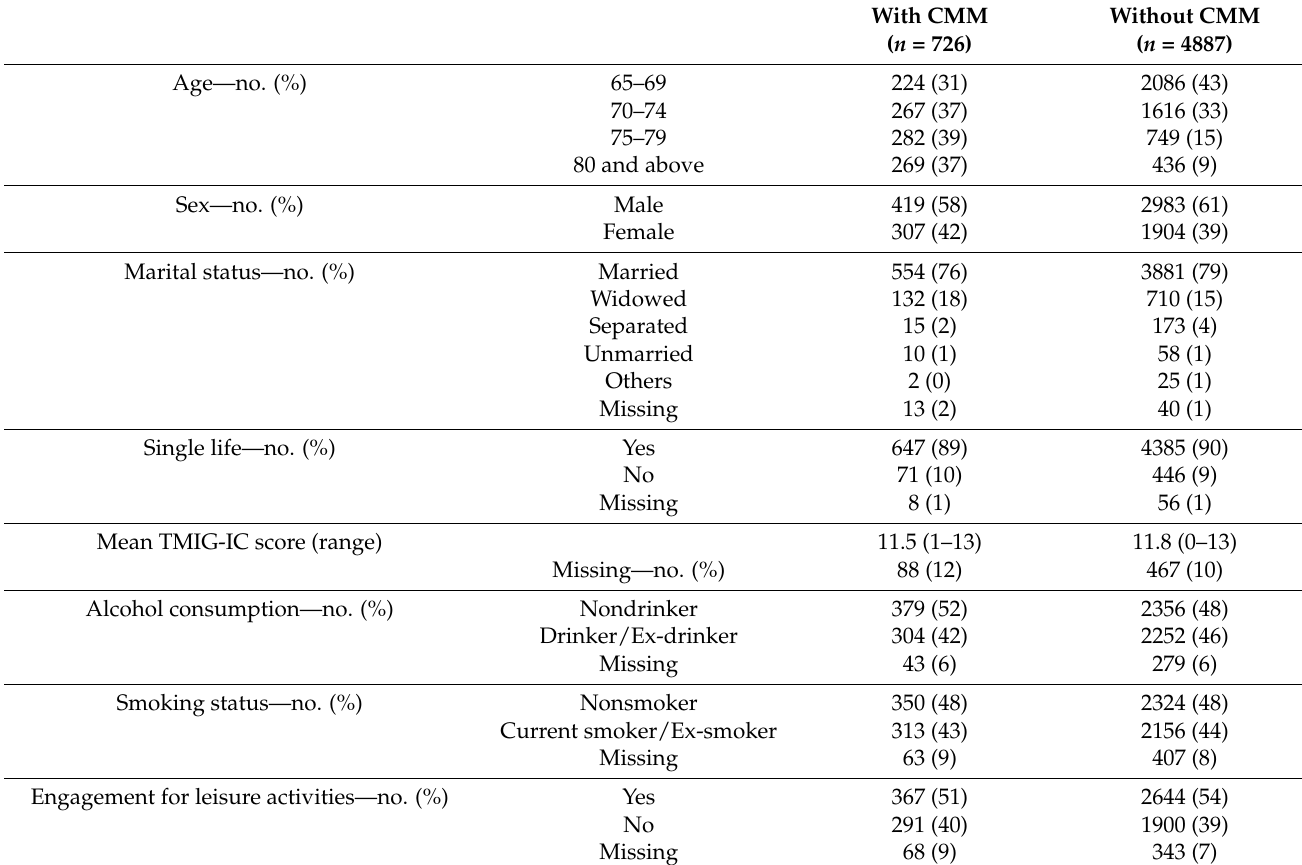
Table 3. Characteristics of participants at baseline and employment rate after